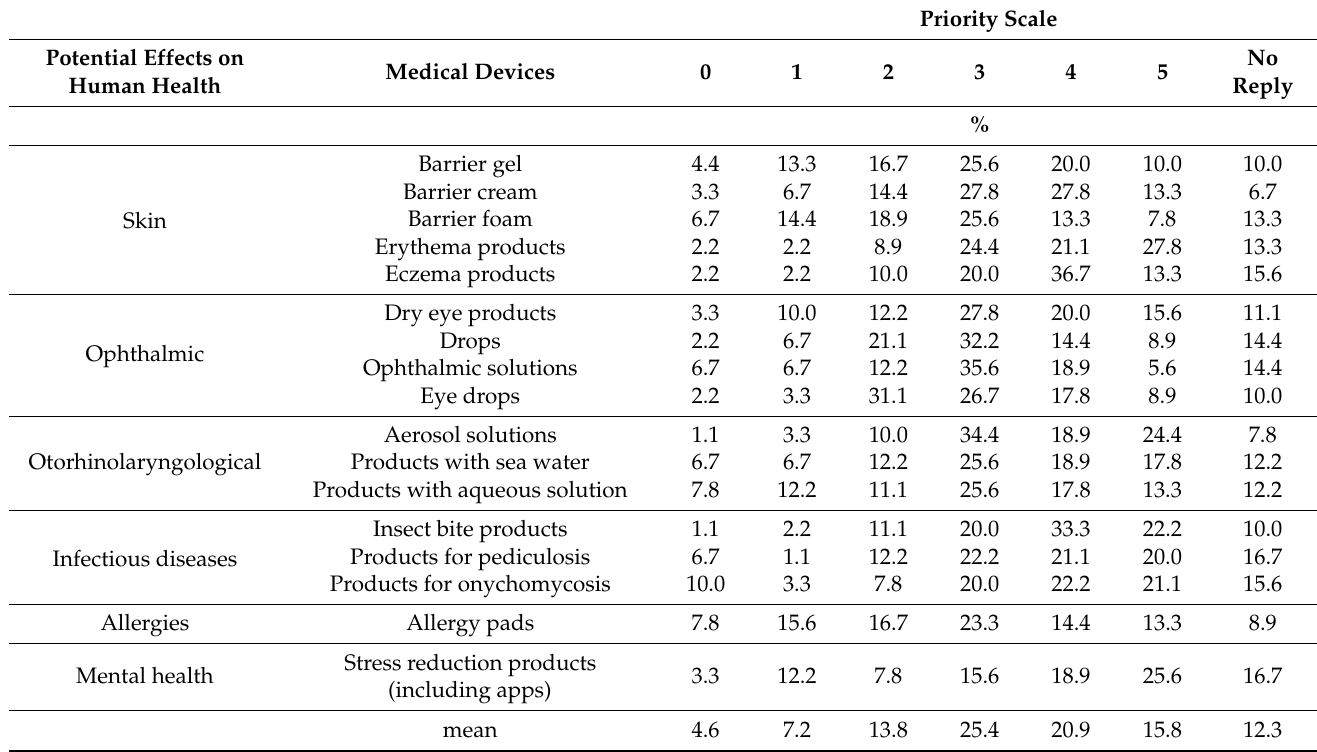
Table 2. Percentages of answers given by pharmacists about which medical devices can mitigate the effects of GEC on human